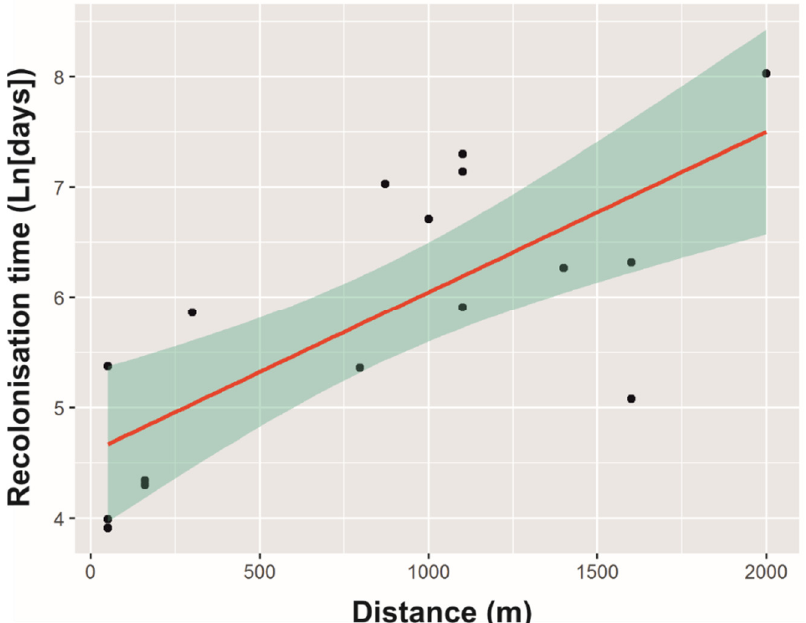
Figure 2. Relationship between the recolonisation time, expressed as Ln (days), and the distance in metres to the nearest colony of Feral Pigeons. A 95% credible interval is denoted by the shaded area.